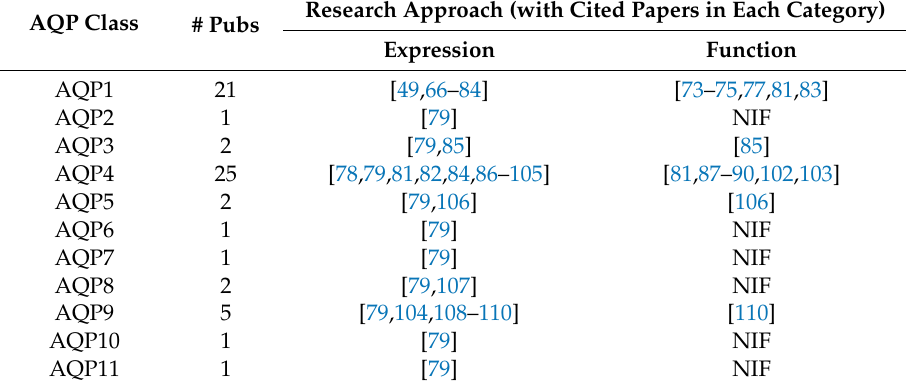
Table 2. Publications on AQPs in glioma, classified by research